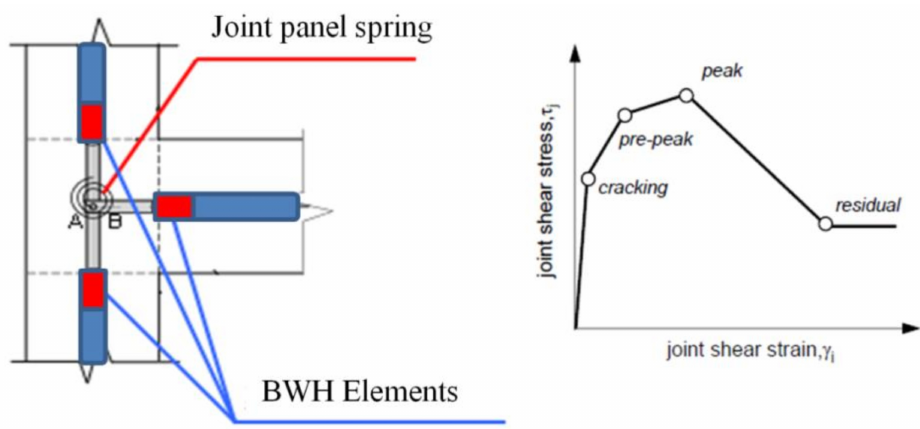
Figure 4. Modeling approach for exterior joint panels.